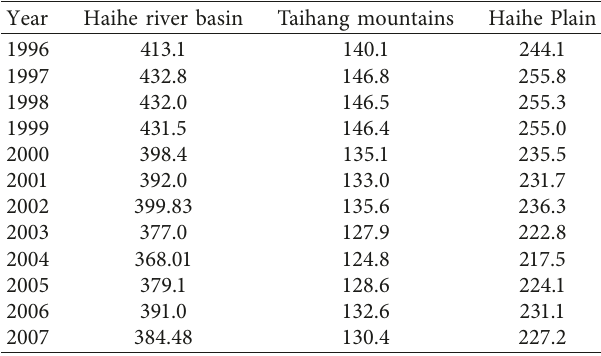
Table 2: Actual statistical water use over the Haihe River Basin and estimated water demands over the Taihang Mountains and Haihe Plain from 1996 to 2007 (unit: 10 8 m 3